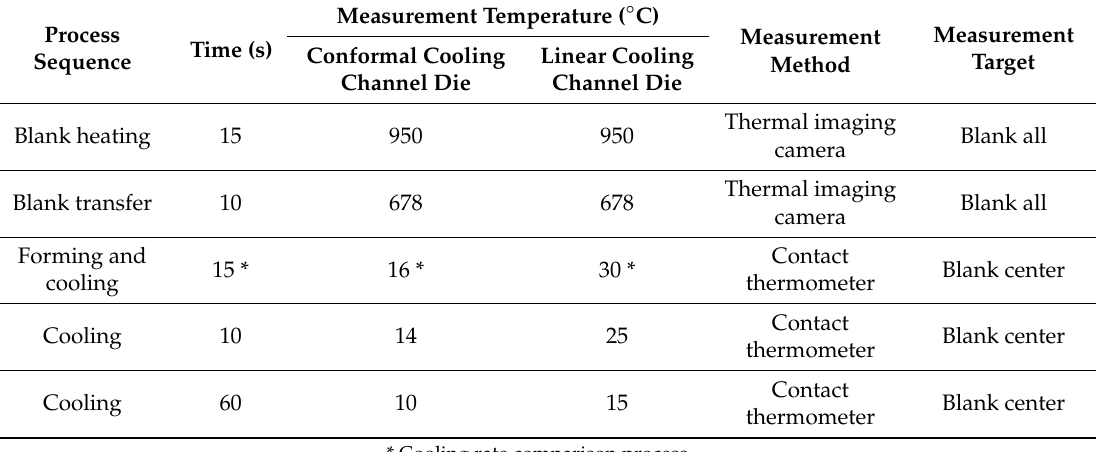
Table 12. Temperature results measured during stamping process.